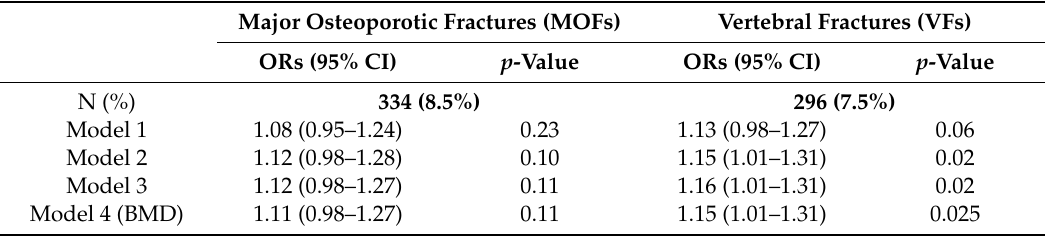
Table 3. Odds ratio of energy-adjusted CML for Major Osteoporotic Fracture (MOF) and vertebral fractures (VFs) in total population with available BMD measurements ( N =